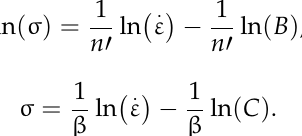
Figure 8. The relationship between ( a ) ln σ —ln